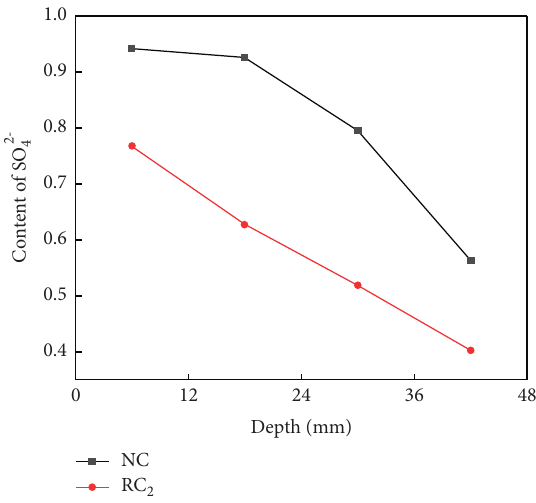
Figure 11: SO 42 − content of NC and RC when dry-wet cycle being 90 times.